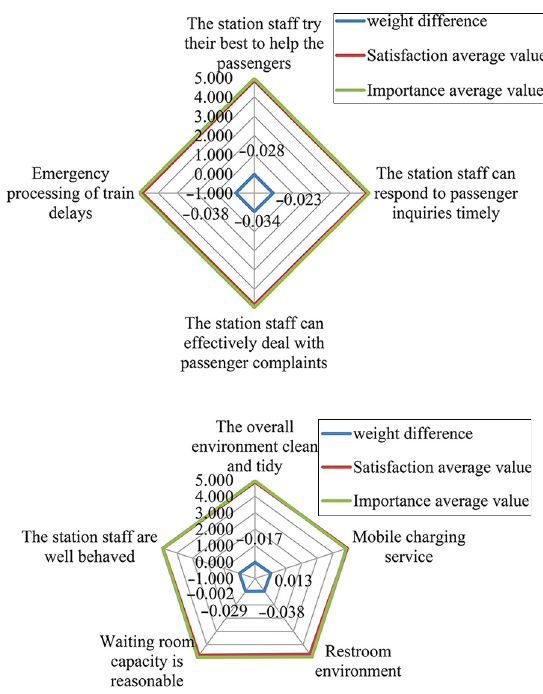
Figure 6. Weight differences